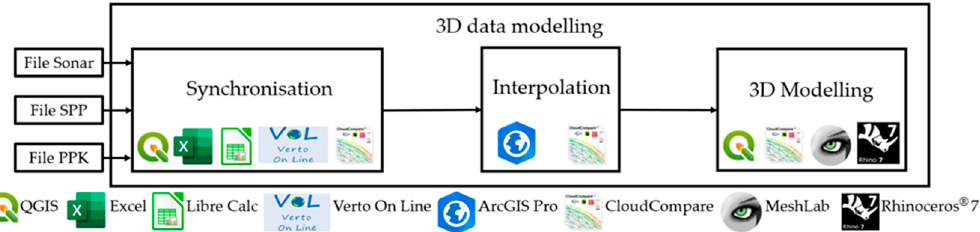
Figure 4. Implementation of the pipeline for 3D modelling of bathymetric data derived from the G > S > P Sys.